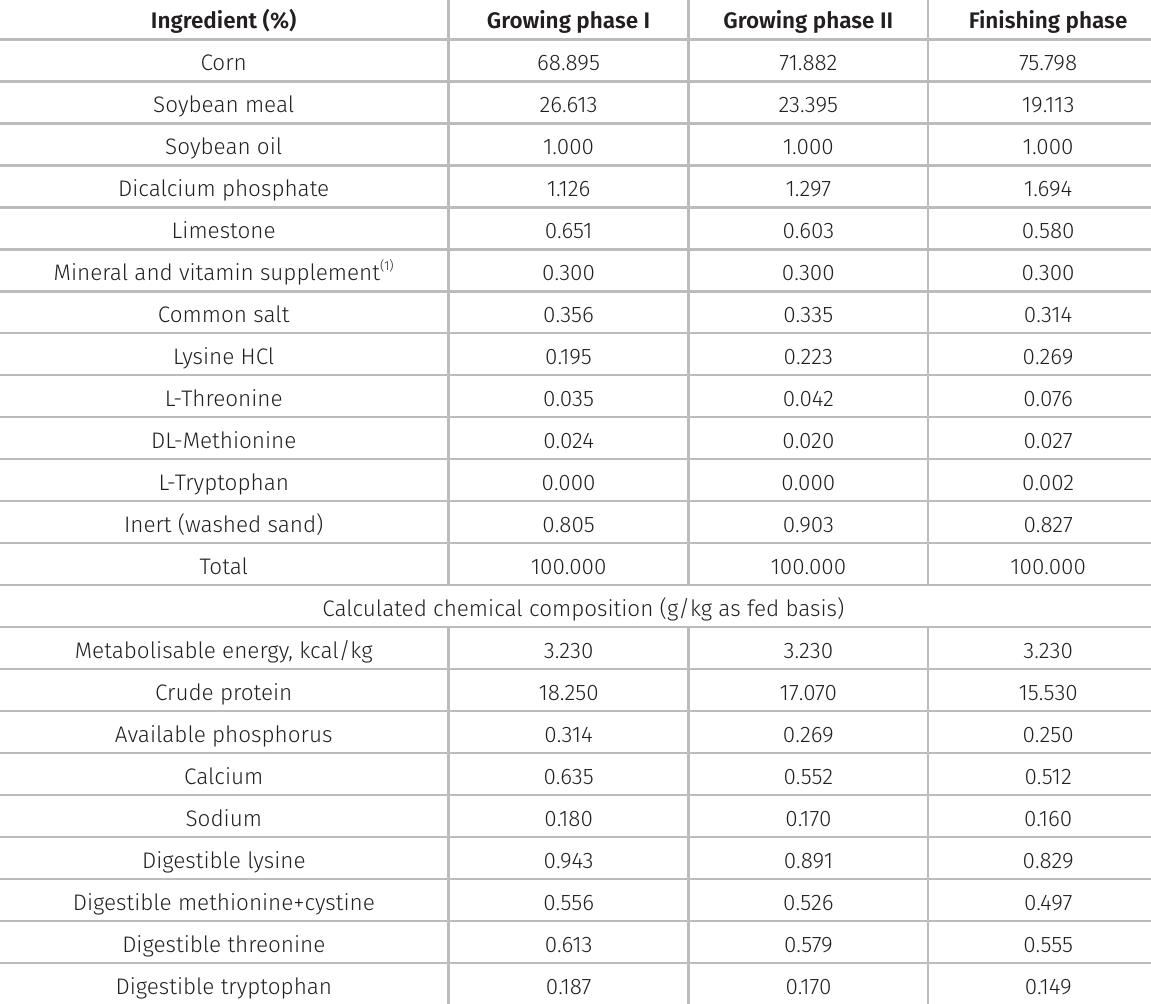
Table I. Ingredients and calculated nutritional composition of experimental diets (g/kg as fed